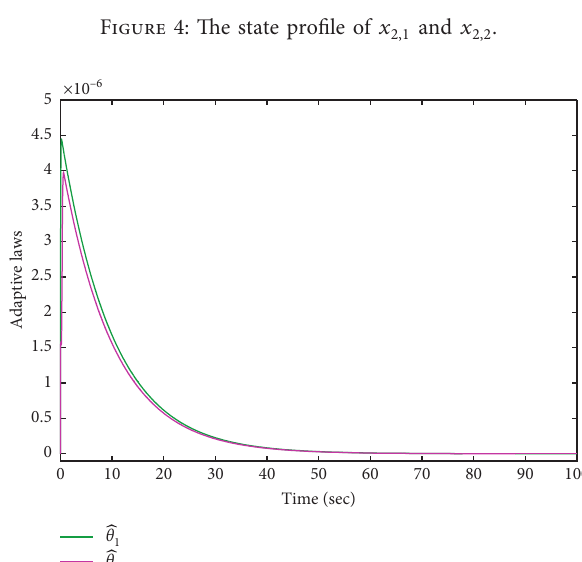
Figure 2: The control input u